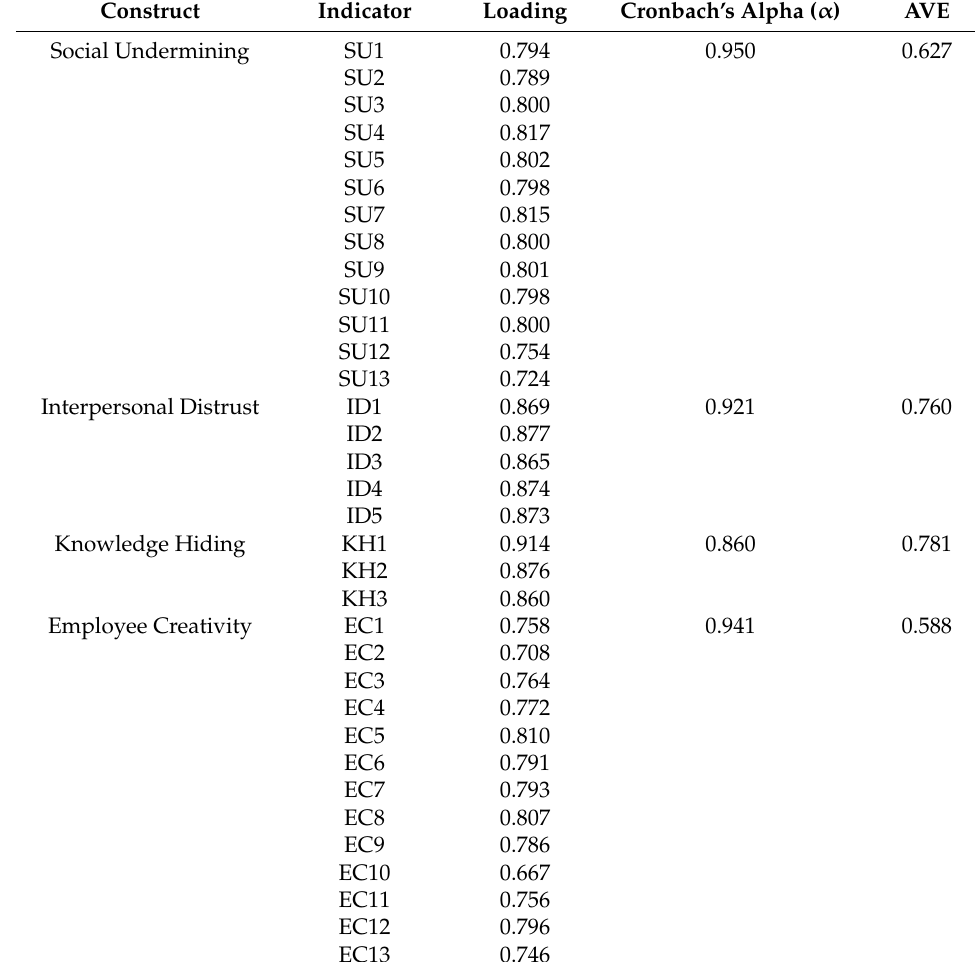
Table 1. Psychometric properties of the scales.